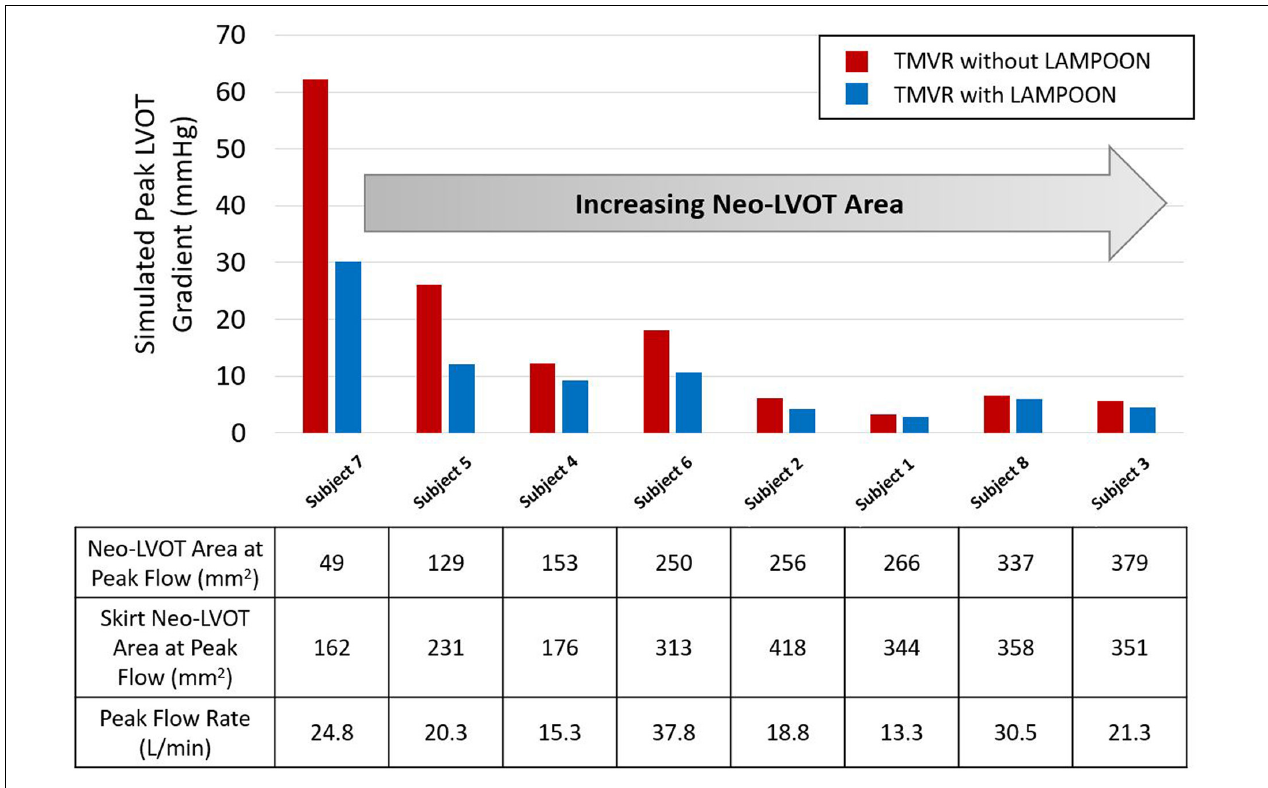
FIGURE 5 | Relationship between post-procedure neo-LVOT area and hemodynamic improvement with LAMPOON. Subjects with a smaller post-procedure neo-LVOT area experienced a greater hemodynamic improvement with LAMPOON. The largest improvement in simulated LVOT gradient (32 mmHg reduction in gradient) was observed in the subject with the smallest post-procedure neo-LVOT area (49 mm 2 ). As neo-LVOT area increased beyond 250 mm 2 , there was a smaller hemodynamic improvement with LAMPOON ( < 2 mmHg reduction in gradient). Neo-LVOT area = cross-sectional area at the narrowest point of the neo-left ventricular outflow tract. Skirt neo-LVOT area = cross-sectional area of the neo-left ventricular outflow tract measured at the level of the transcatheter valve